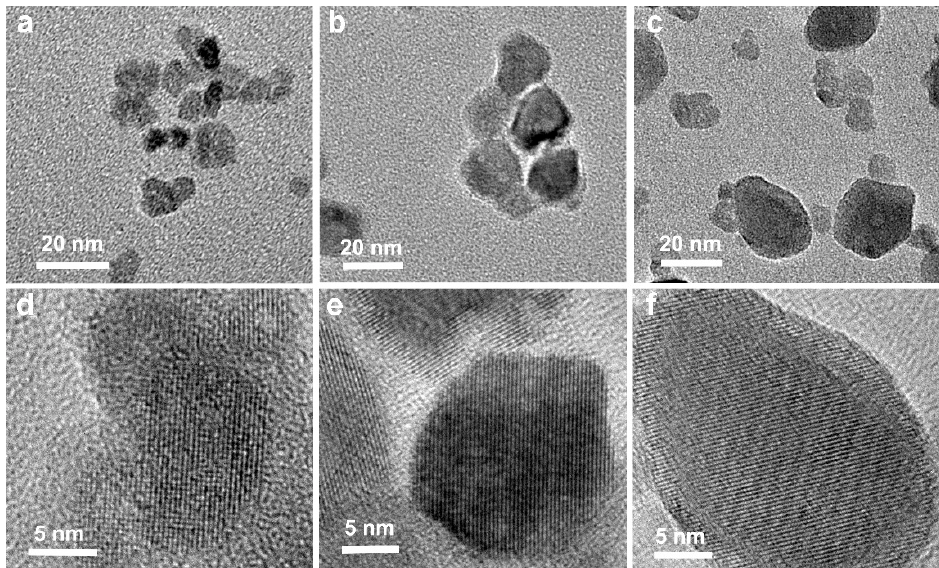
Figure 3. Transmission electron microscopy (TEM) ( a – c ) and HRTEM ( d – f ) images of the as-synthesized (unannealed) YVO 4 :Eu 3+ nanoparticles ( a , d ), the annealed YVO 4 :Eu 3+ nanoparticles ( b , e ) and the YVO 4 :Eu 3+ @YVO 4 :Eu 3+ core-shell nanoparticles ( c , f ).